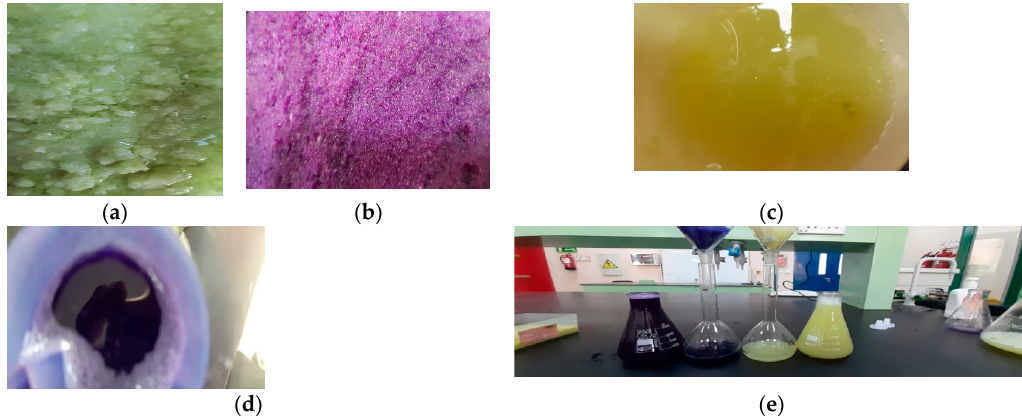
Figure 2. Preparation of RC and GC sensitisers. ( a ) GC fine powder ( b ) RC fine powder ( c ) GC in in ethyl alcohol ( d ) RC in ethyl alcohol ( e ) GC and RC Natural Sensitizers.